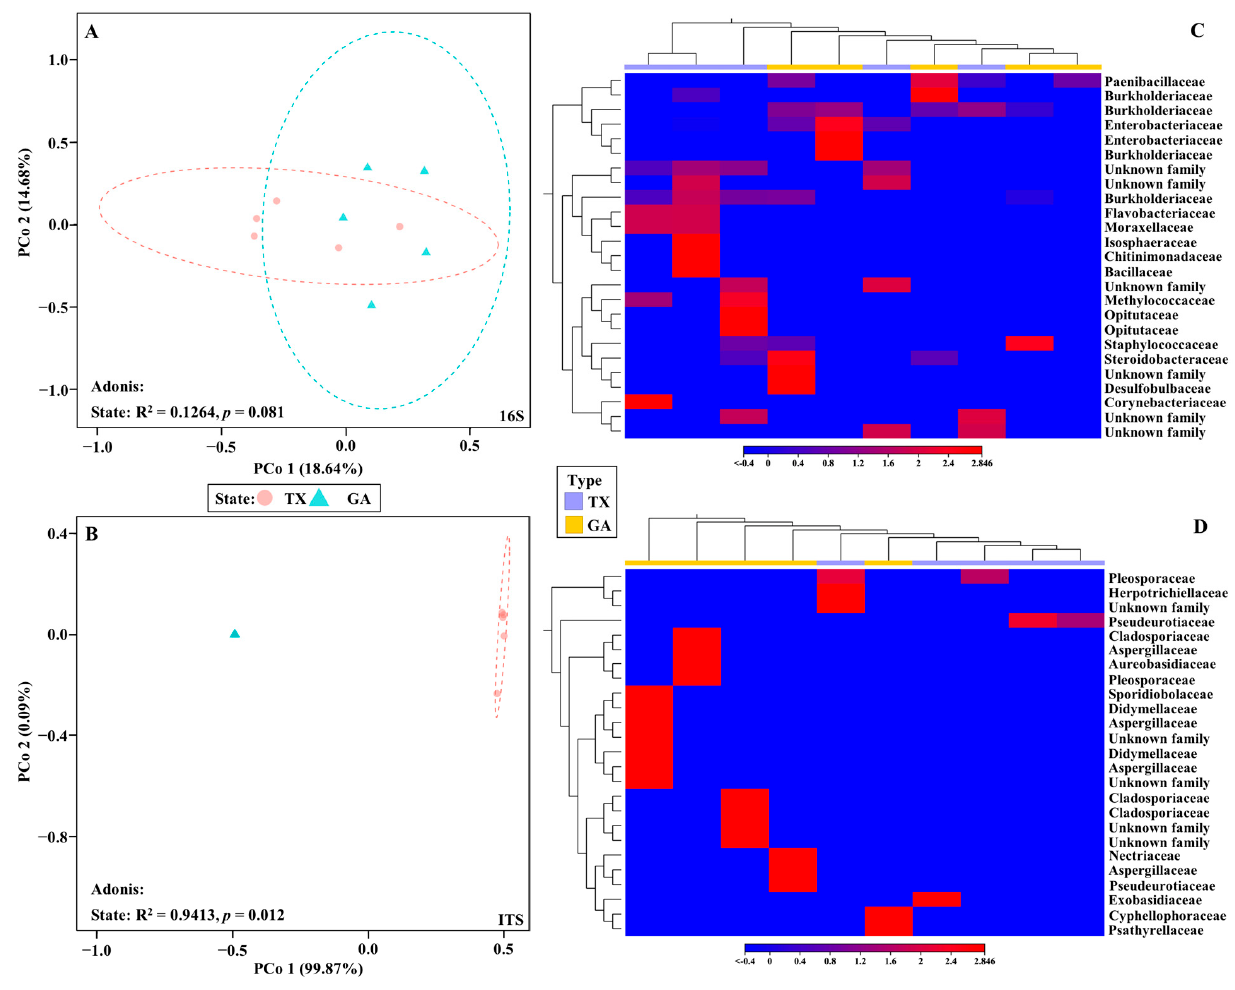
Figure 3. 16S and ITS Beta Diversity. PCoA visualization of bacterial ( A ) and fungal ( B ) populations in seedlings of pecan grown from seeds of the same controlled ‘Lakota’ × ‘Oaxaca’ cross from trees in Texas (TX) and Georgia (GA). The colored shapes represent samples from their respective state (red circle represents Texas and the blue triangle represents Georgia). Heat map visualization of bacterial ( C ) and fungal ( D ) beta diversity in seedlings grown from seeds of the same controlled ‘Lakota’ × ‘Oaxaca’ cross from trees in Texas (TX) and Georgia (GA). Here we show the 25 most abundant OTUs with their taxonomic assignment at the family level.